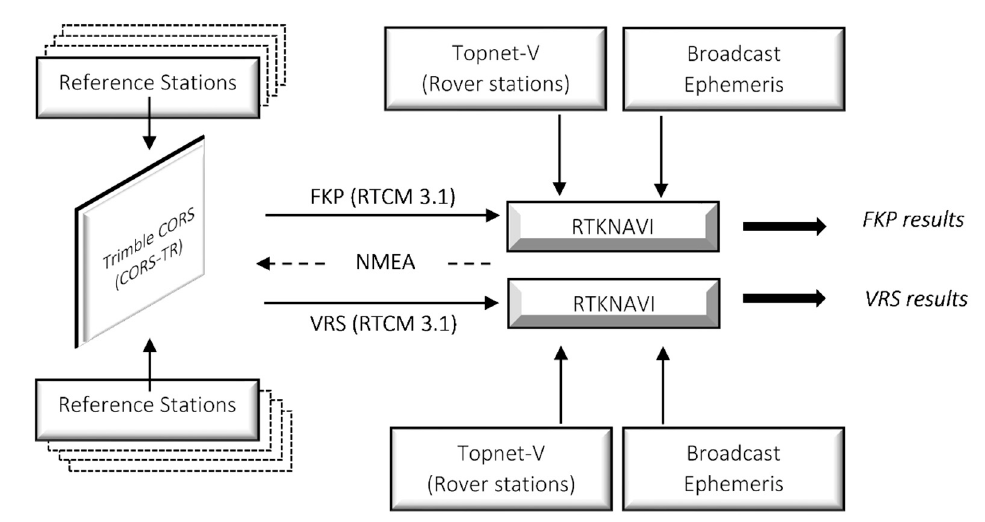
Figure 4. Data communication diagram for FKP and VRS solutions.